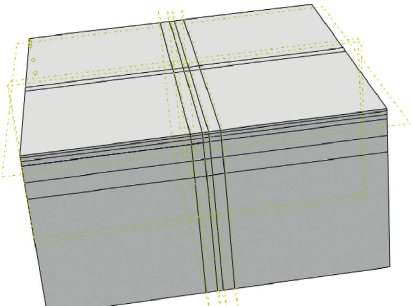
Figure 3: Overall structure diagram of semirigid base asphalt The parameters of the semirigid base asphalt pave- A void area of size 50 cm × 20 cm × 0.5 cm is set in the ment structure materials and polymer grouting middle of the bottom of the base layer, as shown in materials are listed in Table 3 [25]. Figure 4.